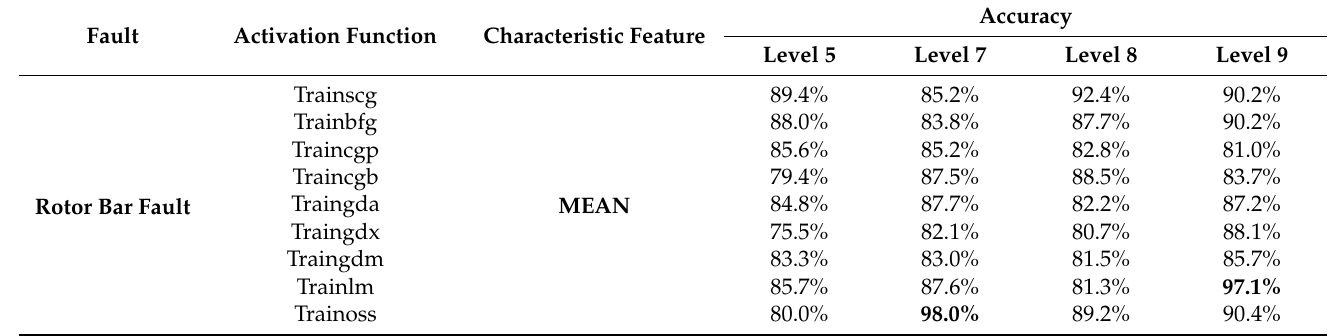
Table 6. Rotor Bar Fault with Mean Feature Accuracies under different Activation